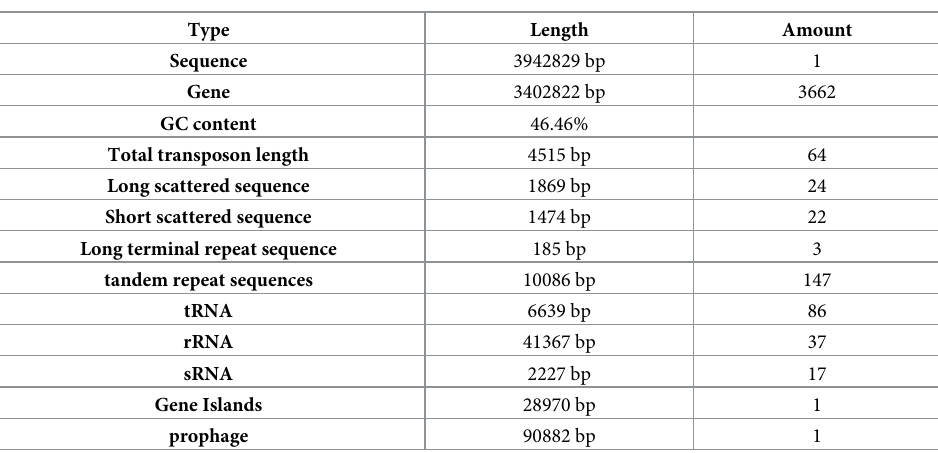
Table 4. Genome statistics of the DW-7